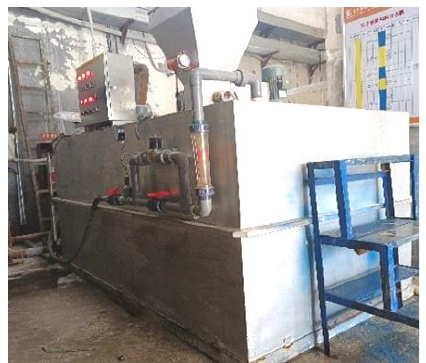
Figure 4. The flocculant addition equipment.